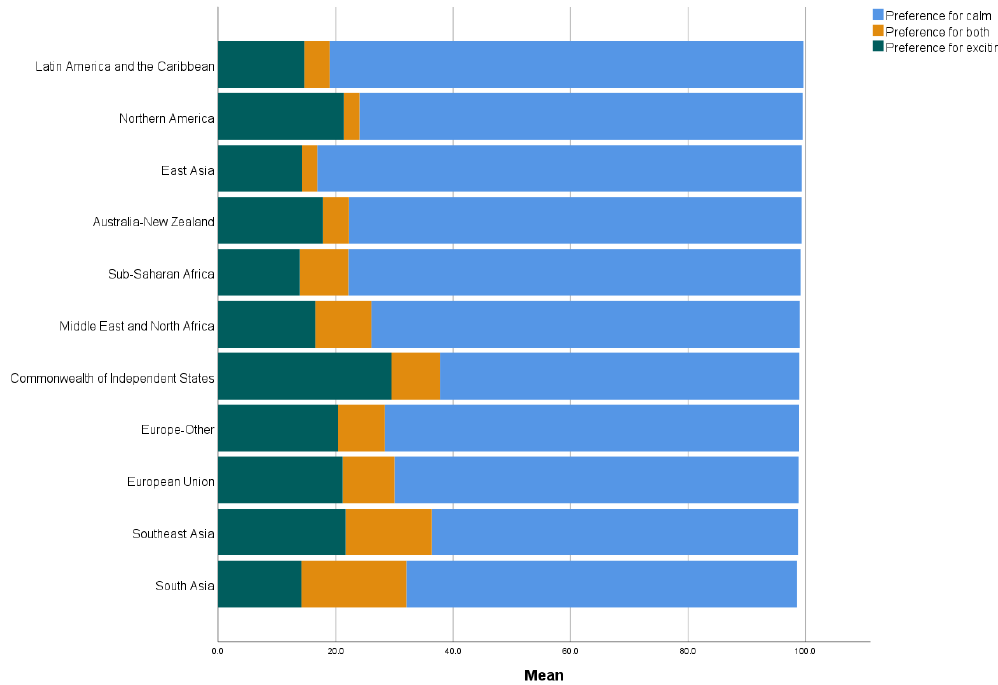
Figure 4. Regional means of preference for a calm life.